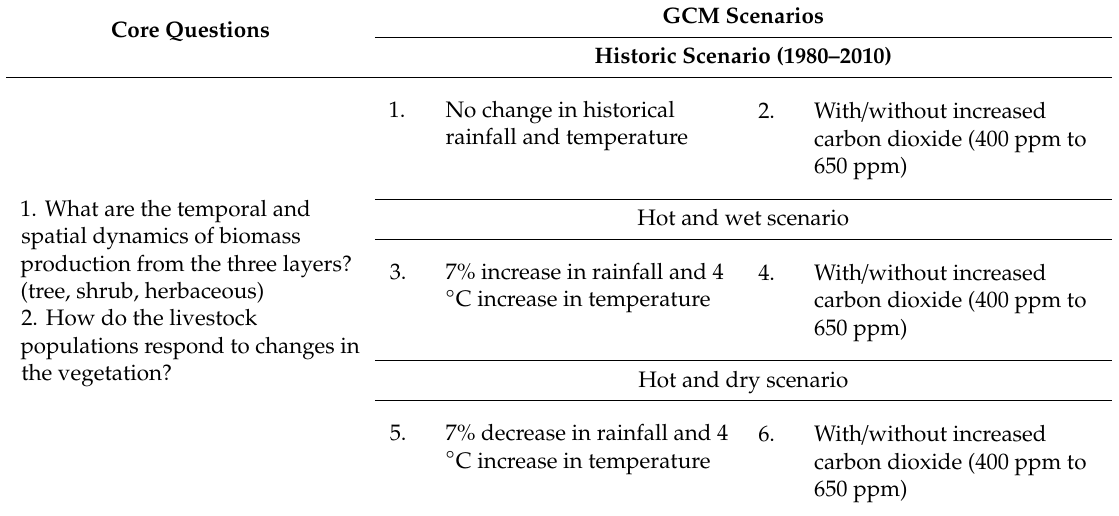
Table 1. Core questions that guide SAVANNA simulations with historic and GCM Scenarios.